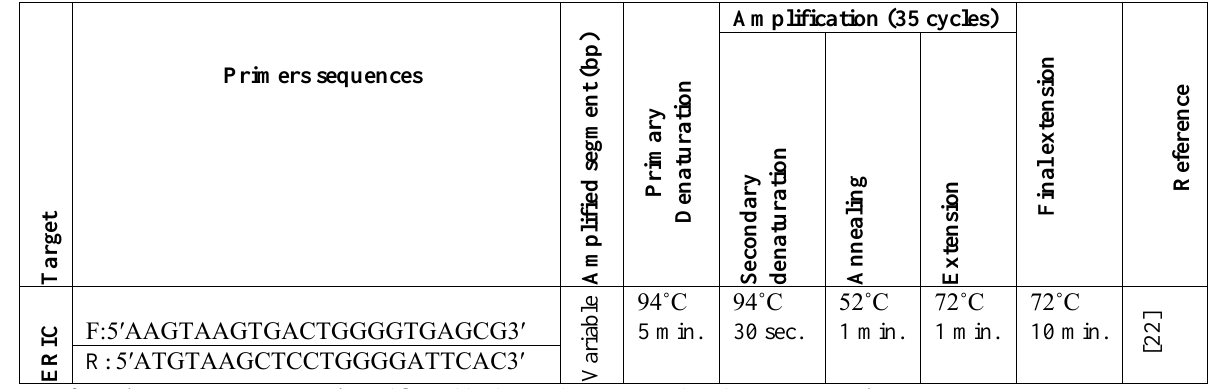
Table 2. Primers sequences, target genes, amplicon sizes and cycling conditions